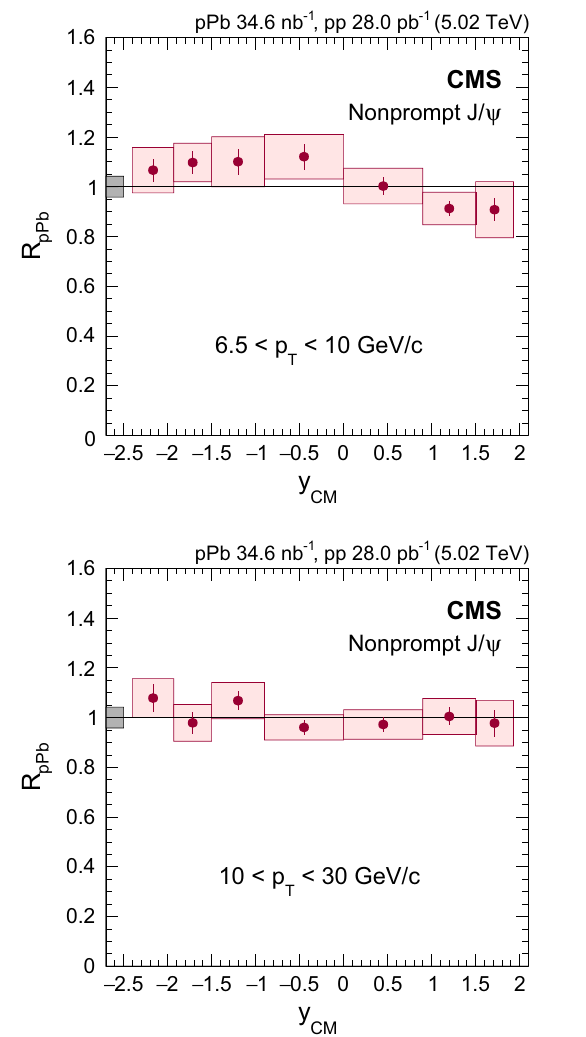
Fig. 11 Rapidity dependence of R pPb for nonprompt J /ψ mesons in two p T ranges: 6 . 5 < p T < 10GeV / c ( upper ) and 10 < p T < 30GeV / c ( lower ). The vertical bars represent the statistical uncer- tainties and the shaded boxes show the systematic uncertainties. The fully correlated global uncertainty of 4.2% is displayed as a gray box at R pPb = 1 next to the left axis